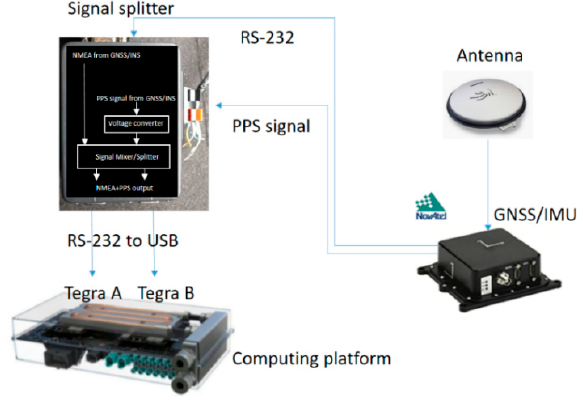
Figure 8. Schematic diagram showing PPS time correction with a signal splitter box.